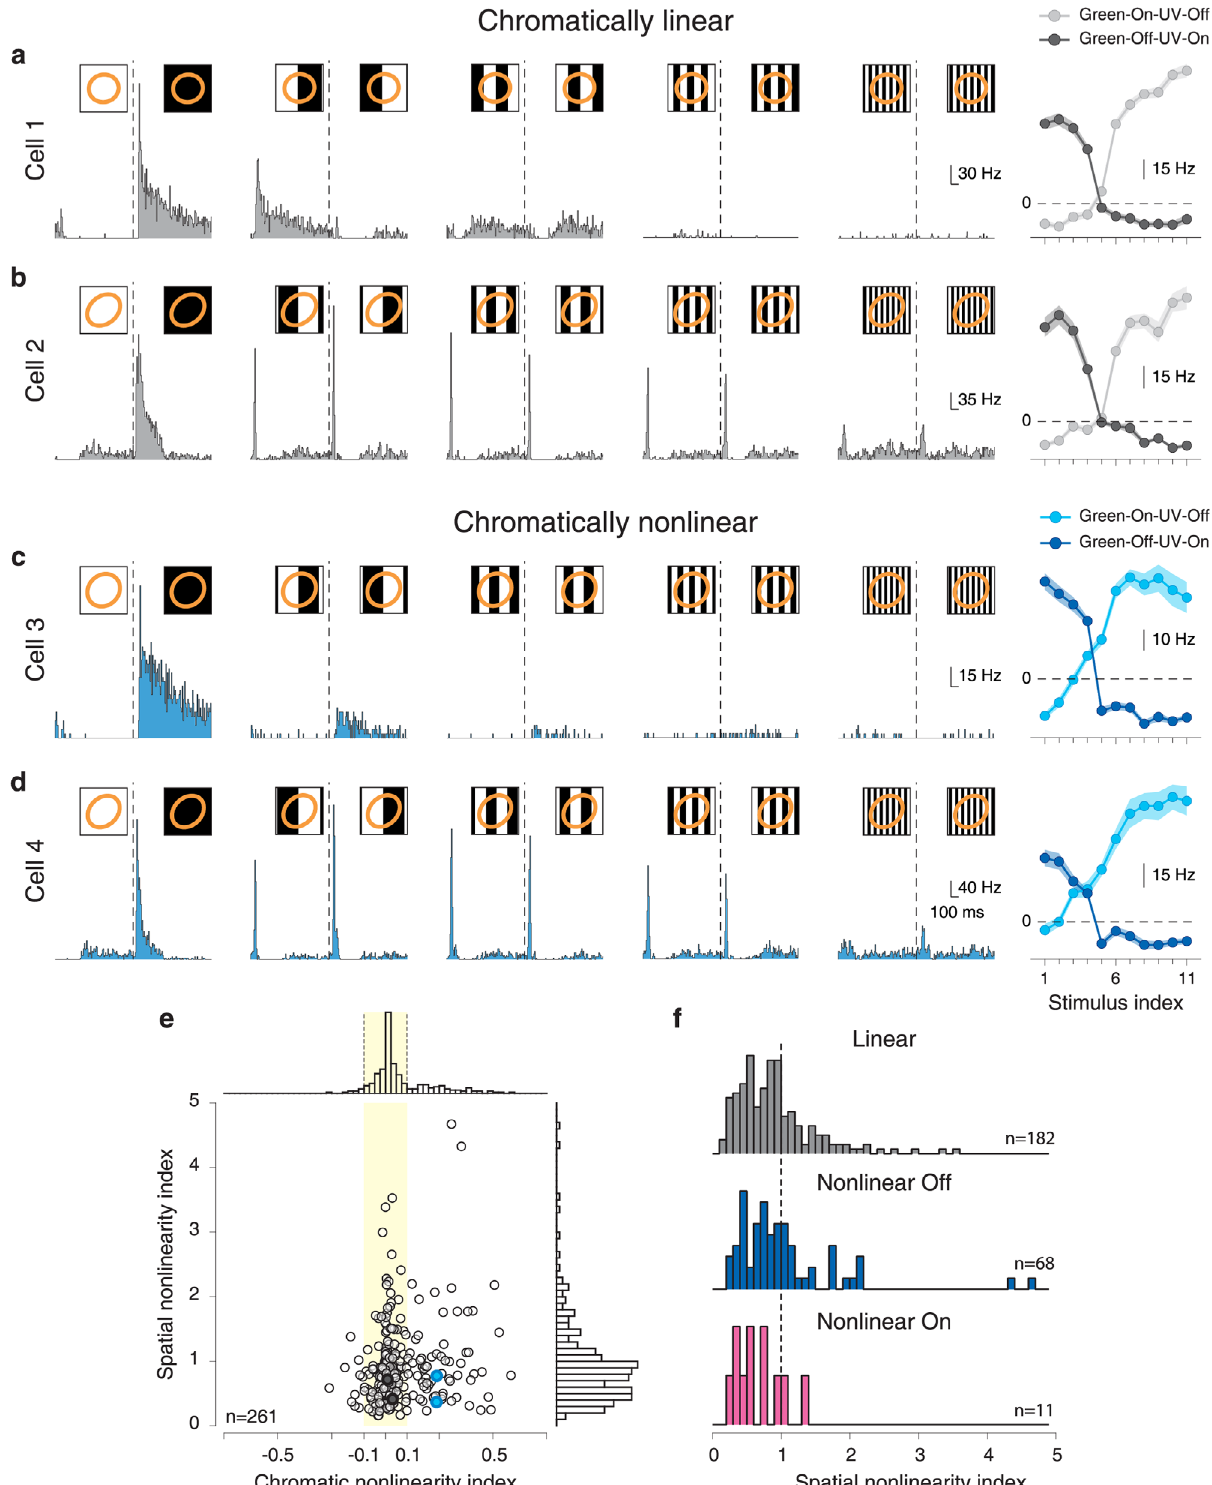
Fig. 4 Chromatic integration is independent of spatial integration. a Responses of a chromatically linear cell to reversing-grating stimuli of different spatial scales, showing linear spatial integration. The dashed lines mark the time of the grating reversal. The insets display the stimulus presented to the cell, together with the 1.5- σ contour of the Gaussian fi t to the receptive fi eld (orange ellipse). To the right: the cell ’ s chromatic-integration curves. b Same as a , but for a chromatically linear cell that shows nonlinear spatial integration. c Same as a , but for a chromatically nonlinear cell that shows linear spatial integration. d Same as a , but for a chromatically nonlinear cell that shows nonlinear spatial integration. The shaded region around the chromatic-integration curves in a – d show mean ± SEM. e Spatial nonlinearity indices of all On and Off cells versus their chromatic nonlinearity indices, displaying only weak correlation (Pearson correlation coef fi cient r = 0.15, p = 0.018, n = 261). Sample cells from a – d are marked by fi lled circles of the corresponding color. f Distribution of spatial nonlinearity indices for chromatically linear as well as for chromatically nonlinear Off and On cells. NATURE COMMUNICATIONS| (2021) 12:1900